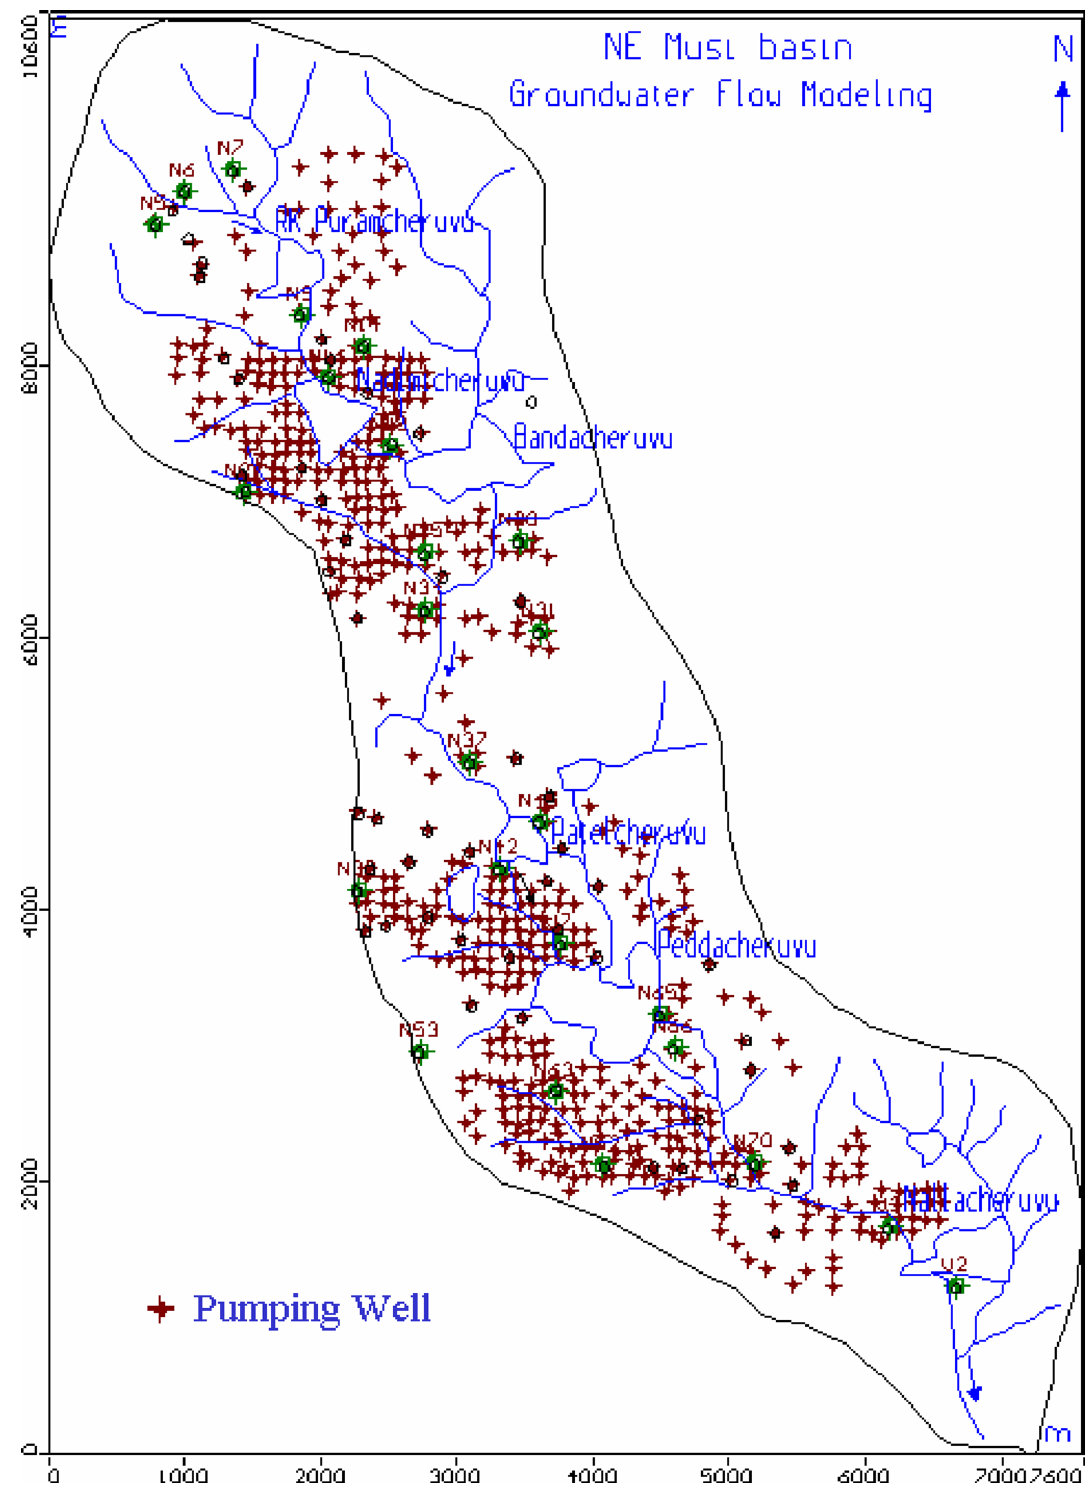
Fig. 4 Pumping centers in groundwater flow